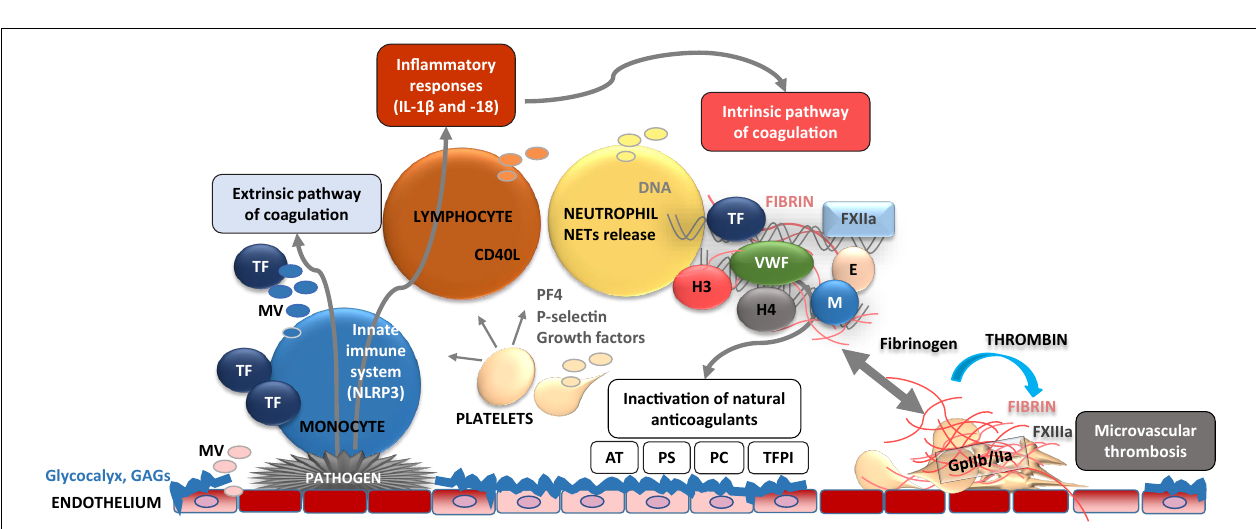
FIGURE 4 | Dynamic cellular and molecular interplay underlying thrombo-inflammation. Pathogen- or danger-signal mediated activation of endothelial cells at the site of disrupted glycocalyx results in adhesion of immune cells (e.g., monocytes) on the cell surface. Activated endothelial and immune cells release microvesicles (MV) bearing, e.g., tissue factor (TF) which induces activation of extrinsic coagulation pathway. TF is also capable to activate NLRP3 inflammasome [subsequent activation of interleukin (IL)-1 β , and IL-18] and inflammatory response. Furthermore, endothelial cell activation results in adhesion of platelets which act as chemo-attractants (e.g., via P-selectin) to neutrophils. As consequence, neutrophil activation results in formation and release of neutrophil extracellular traps (NETs) composed of several pro-inflammatory molecules, neutrophile elastase (E), myeloperoxidase (M), histones (H3 and 4), which perpetuate endothelial dysfunction. NETs activate coagulation FXII and the intrinsic pathway of coagulation. Subsequent enhanced fibrin formation leads to the capture and kill of pathogens in fibrin-strengthened NETs. Procoagulant platelets also release platelet factor 4 (PF4) which inactivates glycosaminoglycans (GAGs) such as heparin. On the other hand,